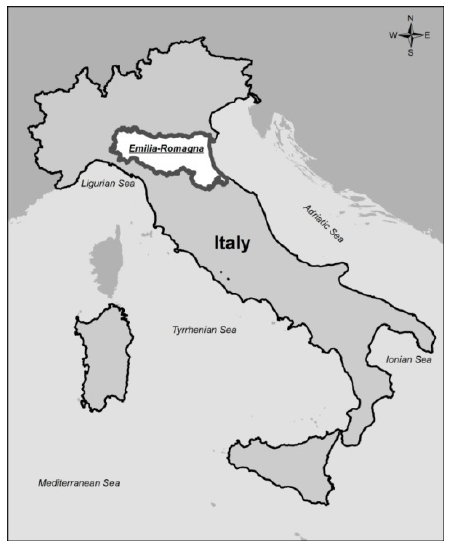
Figure 3. The Emilia-Romagna Region, Italy.